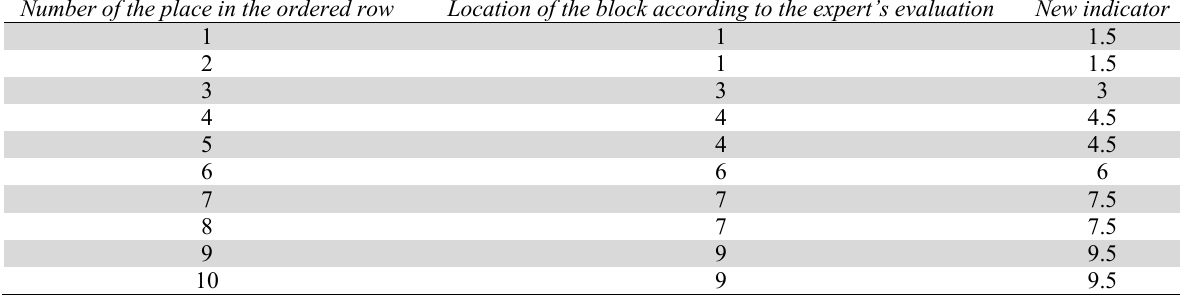
Location of the block according to the expert’s evaluation